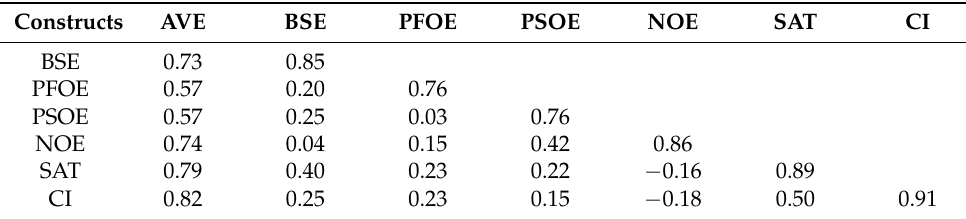
Table 4. Intercorrelations of the latent variables for constructs.